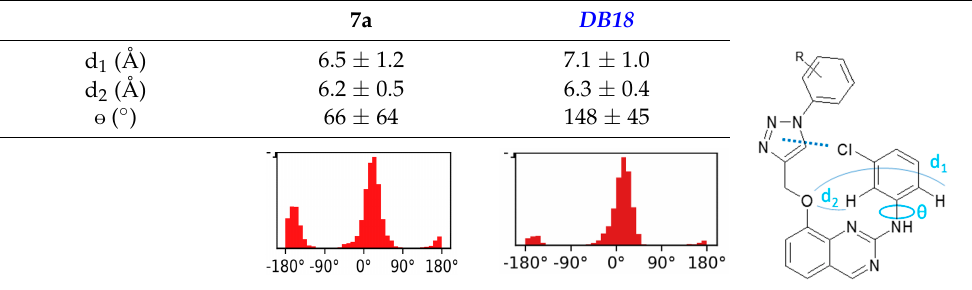
Table 4. Geometric properties of inhibitors during molecular dynamics of the complexes with CLK1 (mean value). The last line represents bar plots of the dihedral (probability density of torsion during the simulation). Note the higher flexibility of 7a , as evidenced by the larger standard devi- ation of its dihedral, as compared with DB18 . The halogen/ π bond is symbolized by a dotted line on the chemical structure (right).